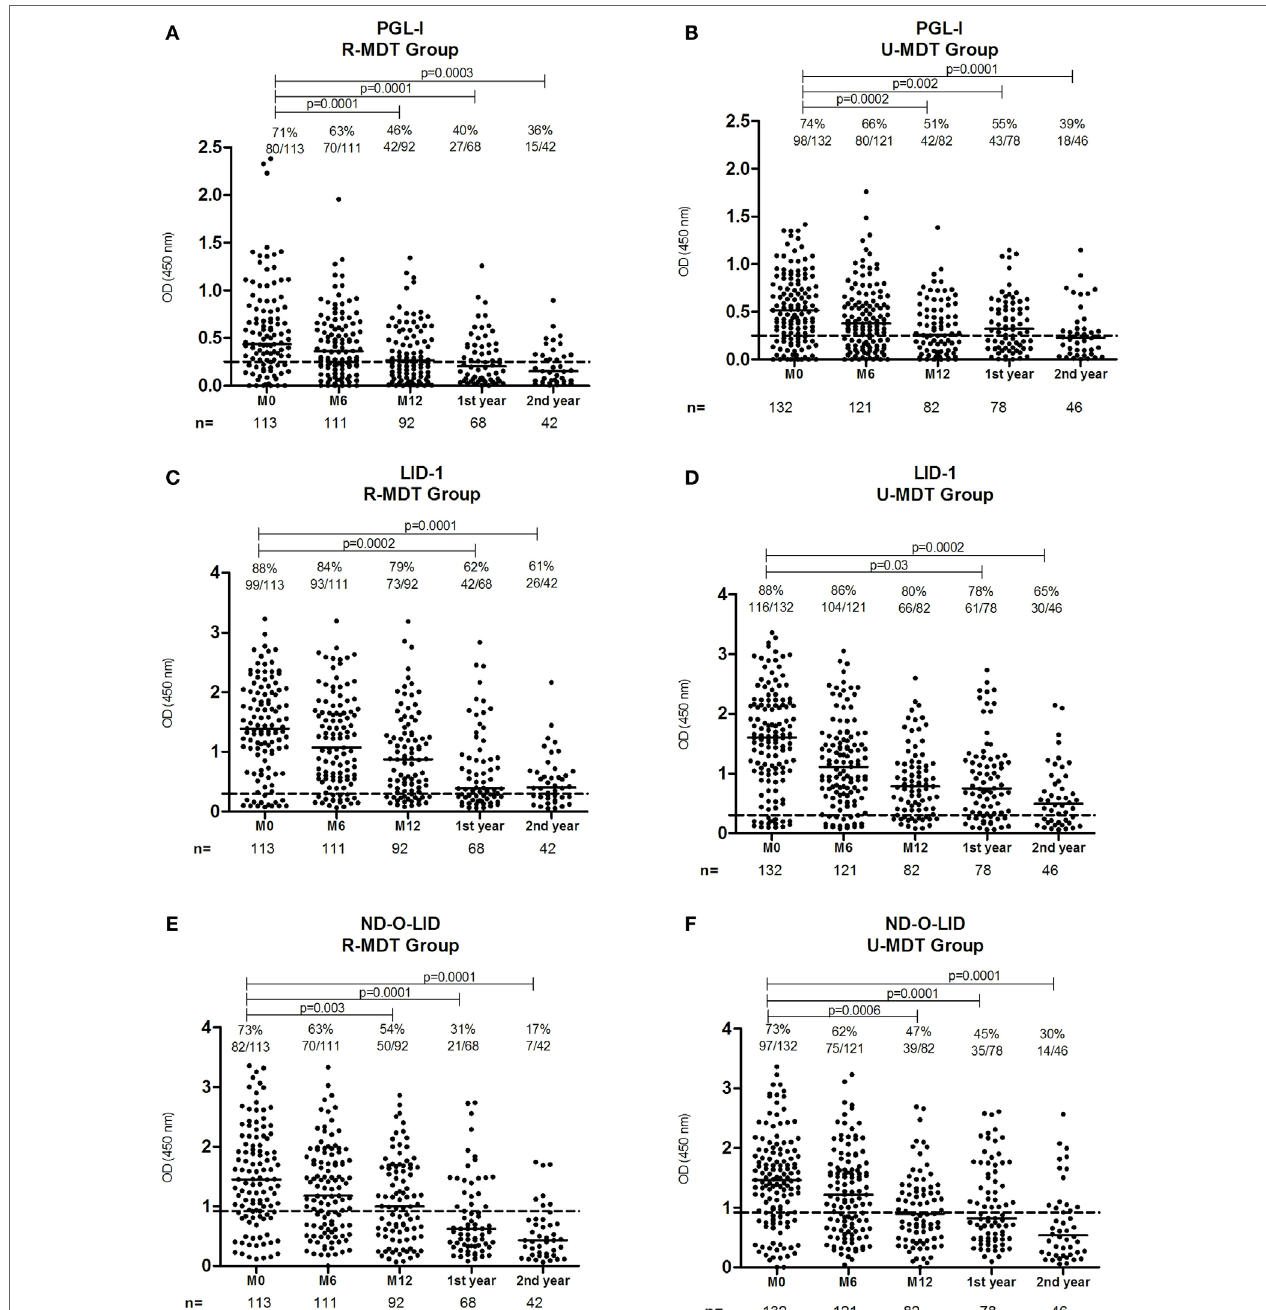
FigUre 2 | Serologic reactivity to phenollic glycolipid-I antigen (PGL-I), LID-1, and ND-O-LID antigens among multibacillary patients from the regular multidrug therapy (R-MDT) and uniform multidrug therapy (U-MDT) groups at different time points MO, M6, M12, and first and second year posttreatment: anti-PGL-I positivity rates in (a) R-MDT group, (B) U-MDT group; anti-LID-1 positivity rates in (c) R-MDT group, (D) U-MDT group; anti-ND-O-LID positivity rates in (e) R-MDT group, (F) U-MDT group. Each point represents the mean optical density (OD) of duplicates of each individual patient. The median OD value of each group is represented by the horizontal line and the traced line represents the different cutoffs (PGL-I OD > 0.25, LID-1 OD > 0.3, and ND-O-LID OD > 0.923). The number above each dataset is the percent of positive responses. The p value refers to differences in positivity rates at different time